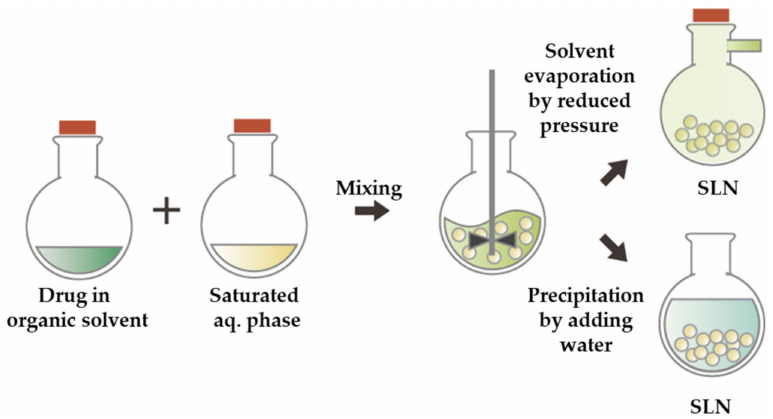
Figure 9. The procedure of emulsification solvent diffusion/evaporation.